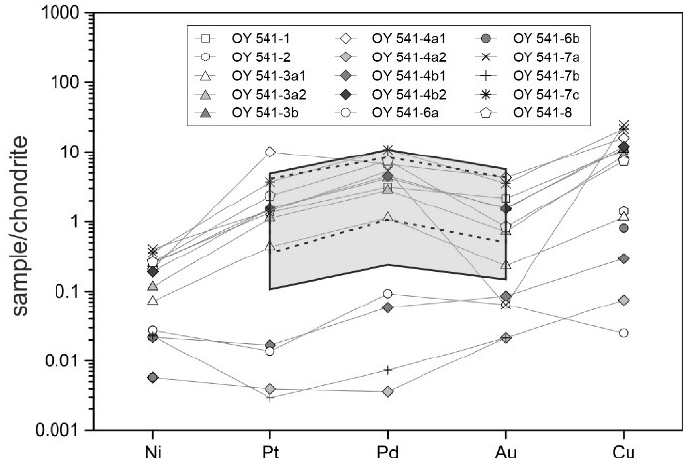
Figure 8. Multi-element diagram of median Ni, Pt, Pd, Au and Cu values (from LA-ICP-MS) normalized against chondrite after McDonough and Sun [70]. The grey polygon represents the bulk Pt, Pd and Au range from Sandsloot, the dashed black line represents the bulk Pt, Pd and Au range from Overysel reef pyroxenites [72], both normalized [73].